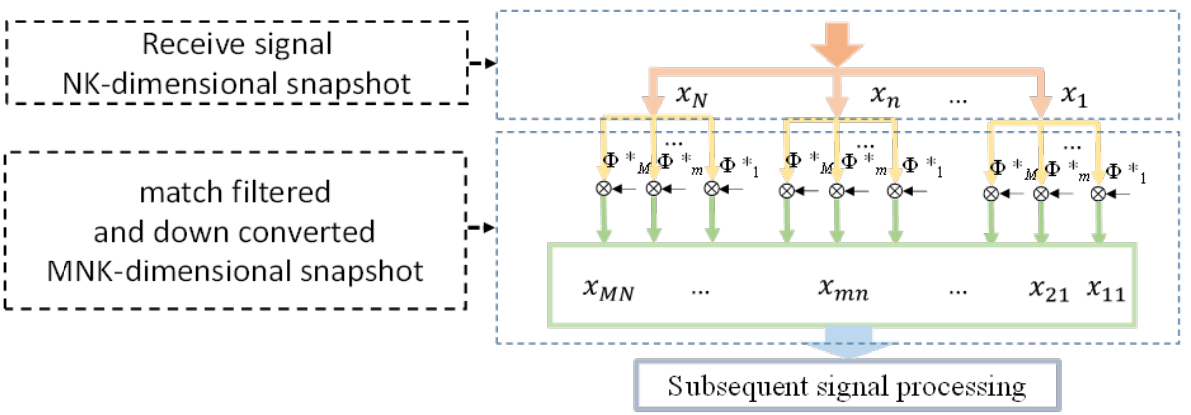
Figure 4. Receiving signal processing block diagram.